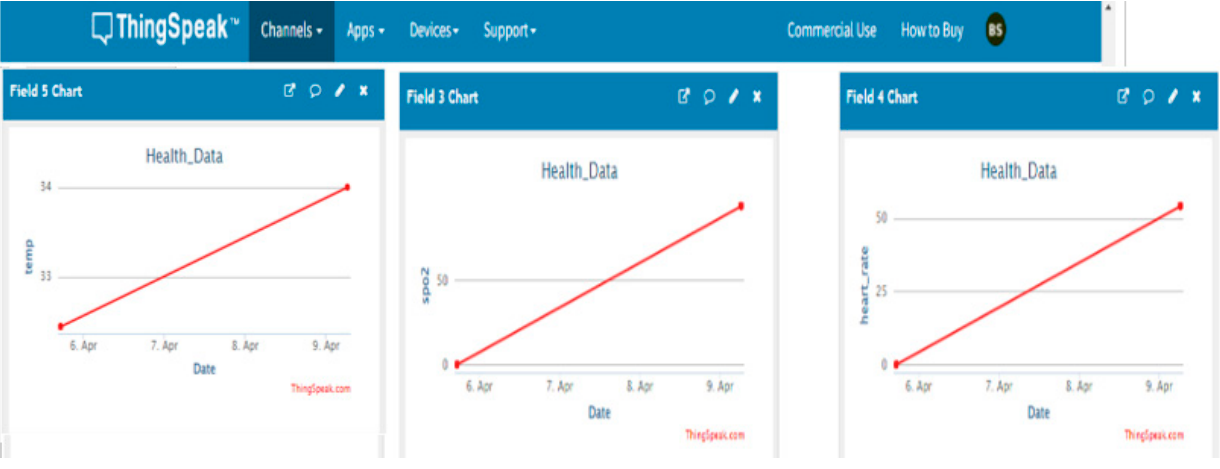
Figure 5. ThingSpeak Health Data Display.